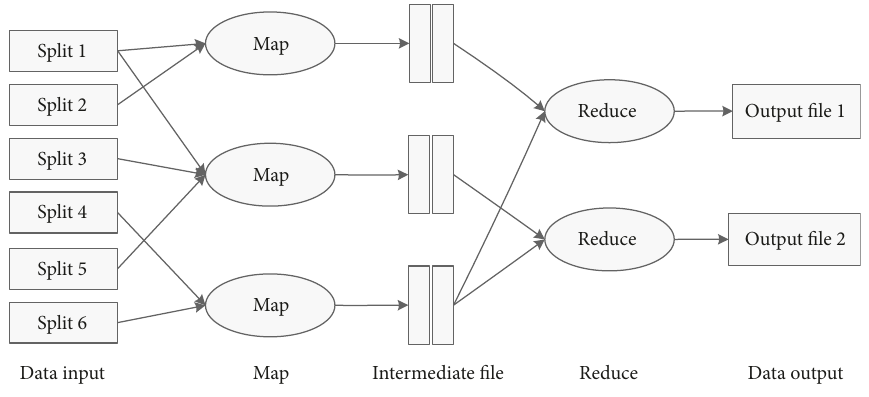
Figure 3: Hadoop MapReduce fl